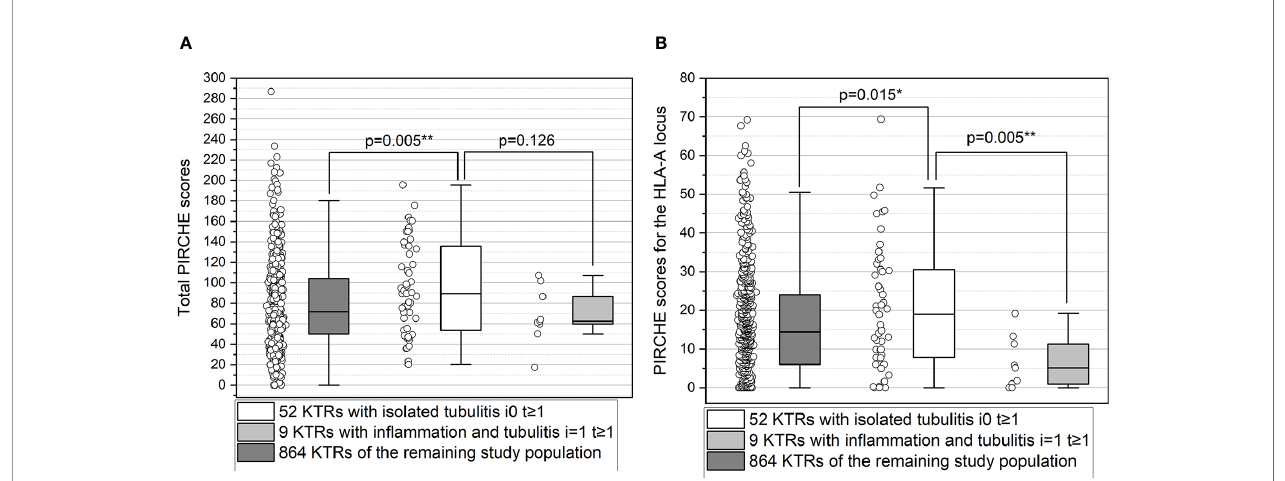
FIGURE 4 | (A, B) Higher total PIRCHE scores (A) and PIRCHE scores for HLA-A locus mismatches (B) among KTRs with isolated tubulitis compared to KTRs with in fl ammation and tubulitis. Boxplots show median, interquartile range (IQR), and 95 th percentile. * signi fi cance level p<0.05; ** signi fi cance level